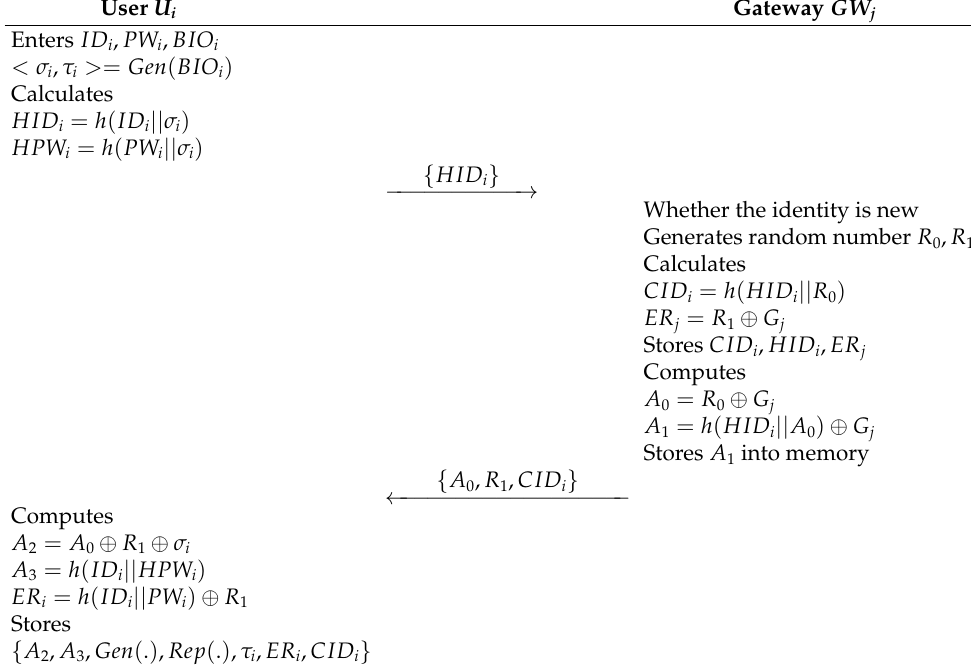
Figure 4. User Registration of the proposed